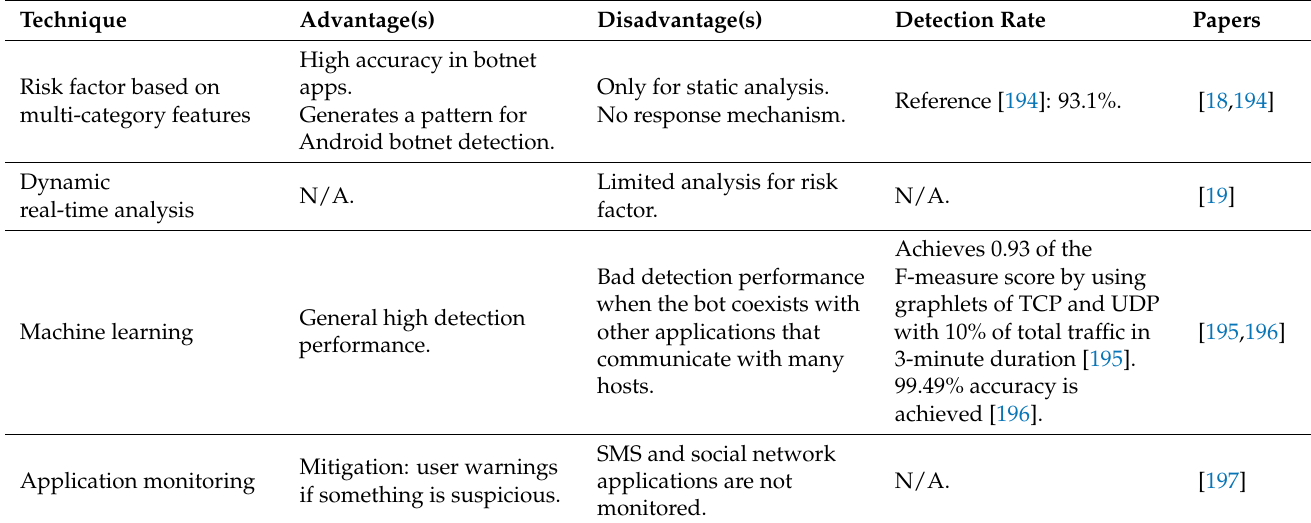
Table 8. Papers describing detection of botnets in mobile devices. Each column describes the overall technique, known advantages, disadvantages, detection rate and related papers,